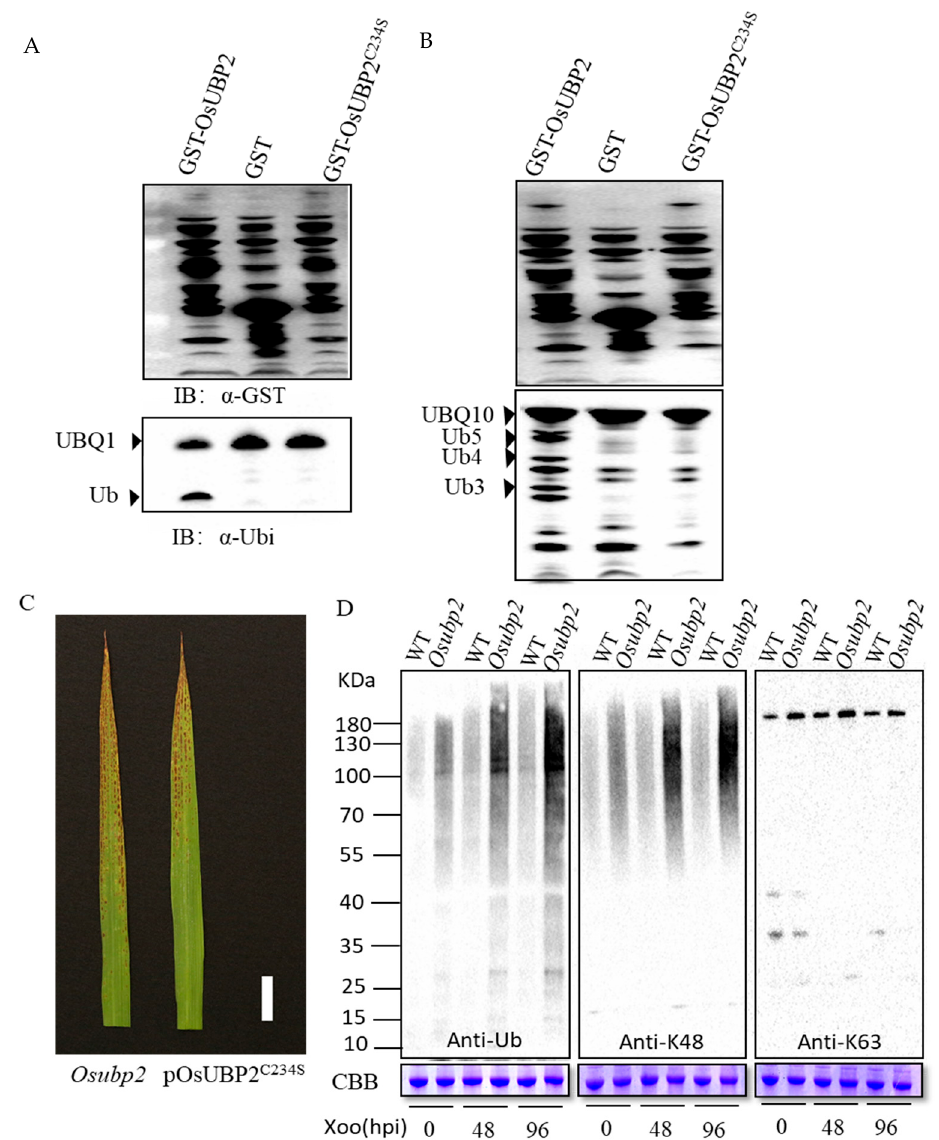
Figure 3. Characterization of OsUBP2 protein. ( A , B ) show the DUB enzyme activity of OsUBP2 and OsUBP2 C234S protein in vivo, detected by the degradation of the substrate AtUBQ1 in ( A ) and AtUBQ10 in ( B ) into small fragments. IB, Immunoblot; Ub, ubiquitin. ( C ) Leaves of Osubp2 and POsUBP2 C234S transgenic T1 plants in Osubp2 background at the heading stage. ( D ) The ubiquitin conjugates in WT and Osubp2 mutant before and after Xoo isolate P6 inoculation. Total protein extracts from seedlings before or after Xoo infection were analyzed using anti-ubiquitin (Ub), anti-K48-linked (K48) or anti-K63-linked (K63) ubiquitin chain antibodies. CBB, Coomassie blue staining, hpi: hours post-inoculation.